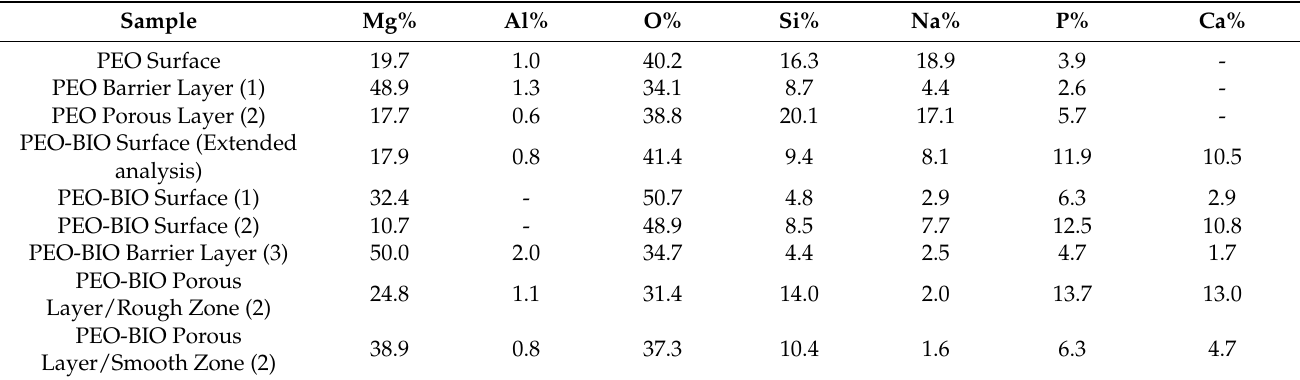
Table 1. Qualitative EDS analysis (wt%) of the surface and of the cross section of the PEO and PEO-BIO samples.